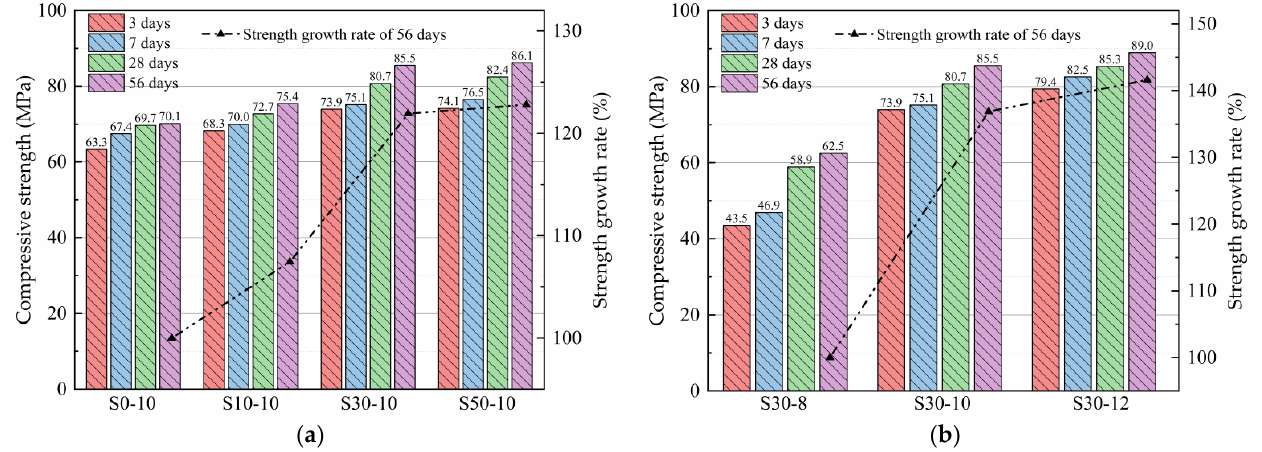
Figure 3. Compressive strength of the alkali-activated metakaolin-based geopolymer specimens according to the ( a ) slag and ( b ) Na 2 O content.